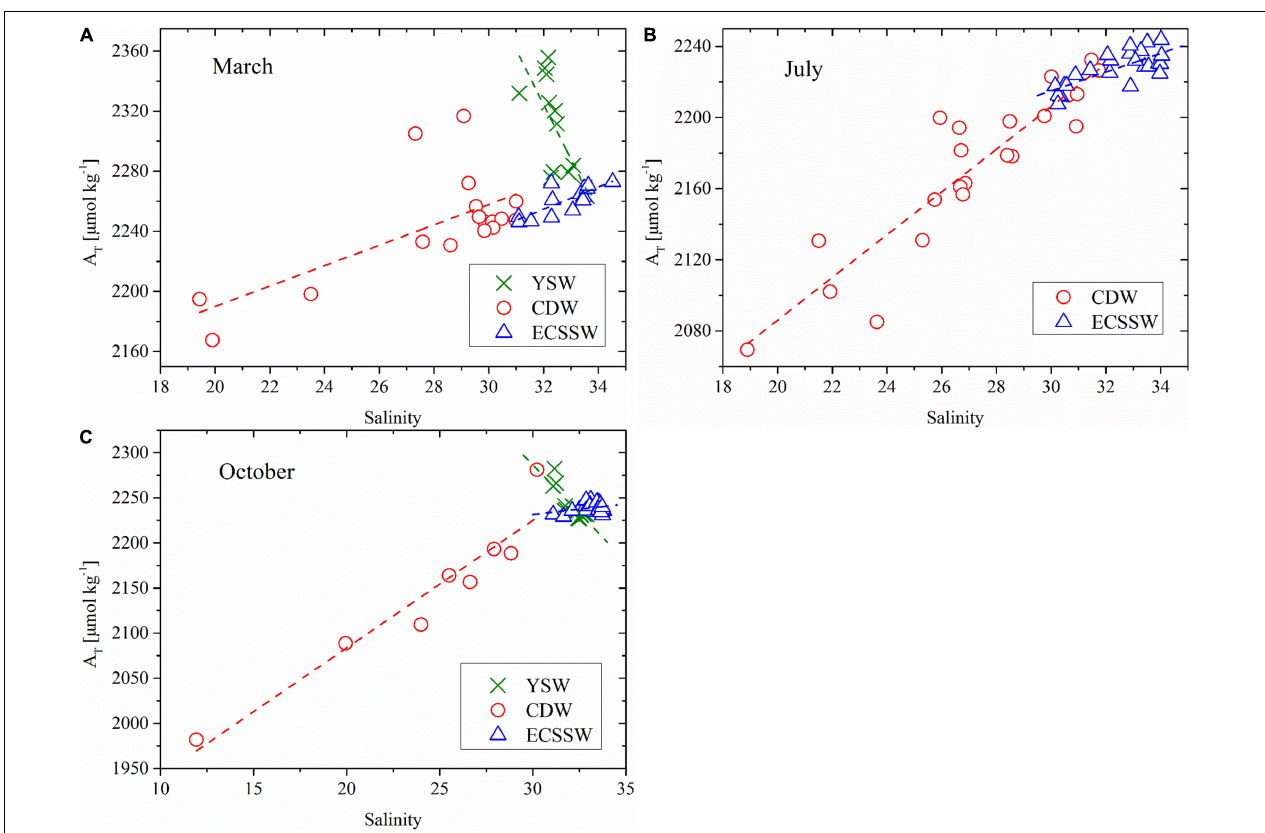
32.34 in July, and 33.16 in October), the calculated A T results were 2276.83, 2234.30, and 2269.66 µ mol/kg, respectively, which were very close to the observed average A T values of the ECSSW ( Supplementary Table 1 ). This indicates mixing between the